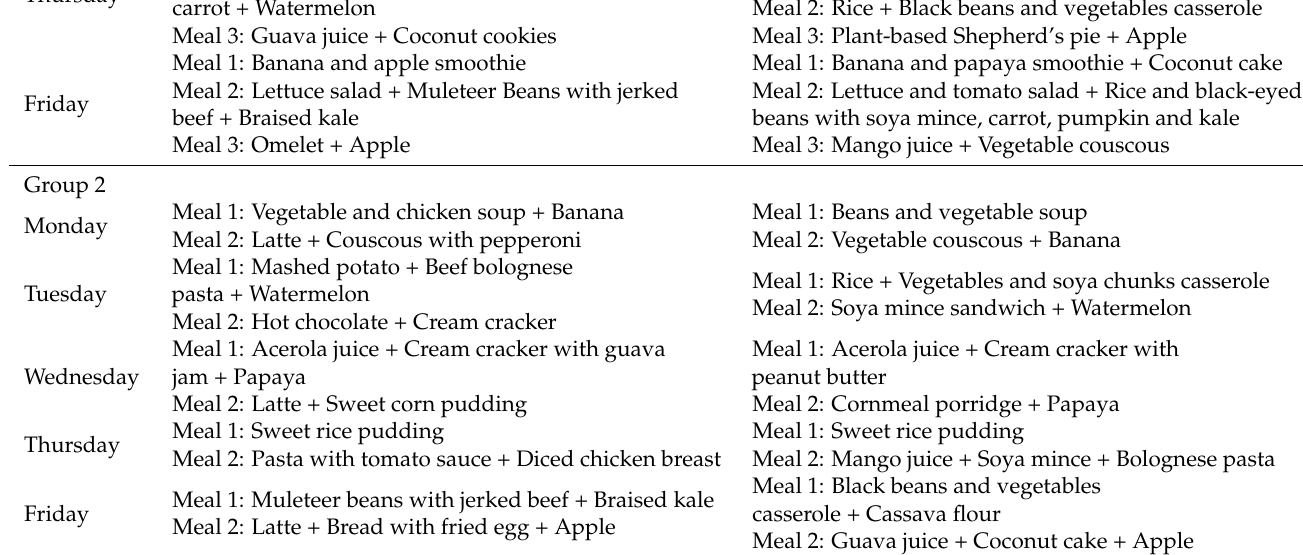
Meal 1: Black beans and vegetables casserole + Cassava flour Meal 2: Guava juice + Coconut cake +